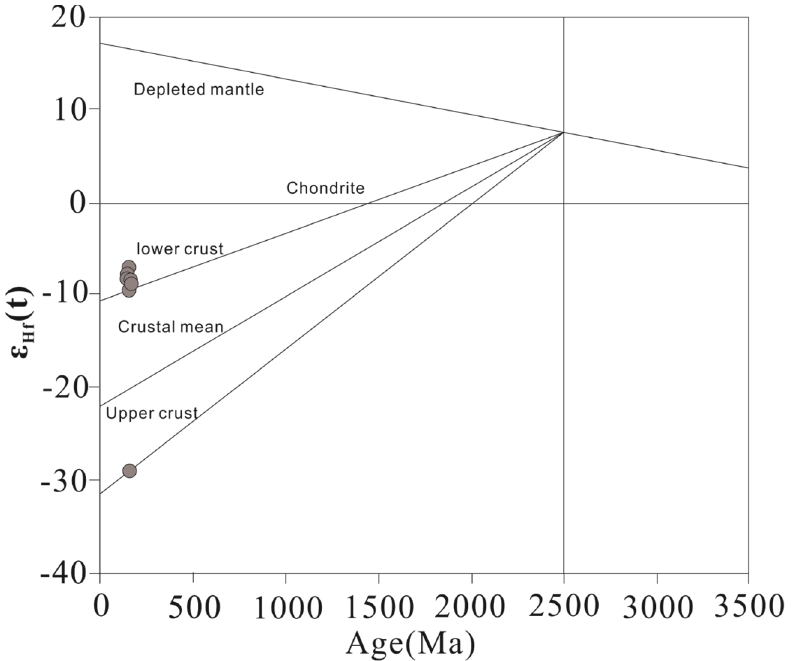
Figure 12. Plot of ε Hf(t) vs. U-Pb age of zircon grains from the No. 3 granodiorite.